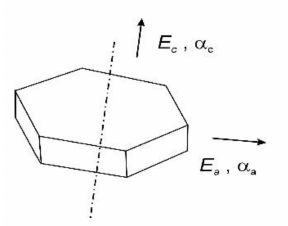
Figure 8. Definition of anisotropy of the graphite powder used in the model: a —perpendicular to the central axis; c —parallel to the central axis [37].